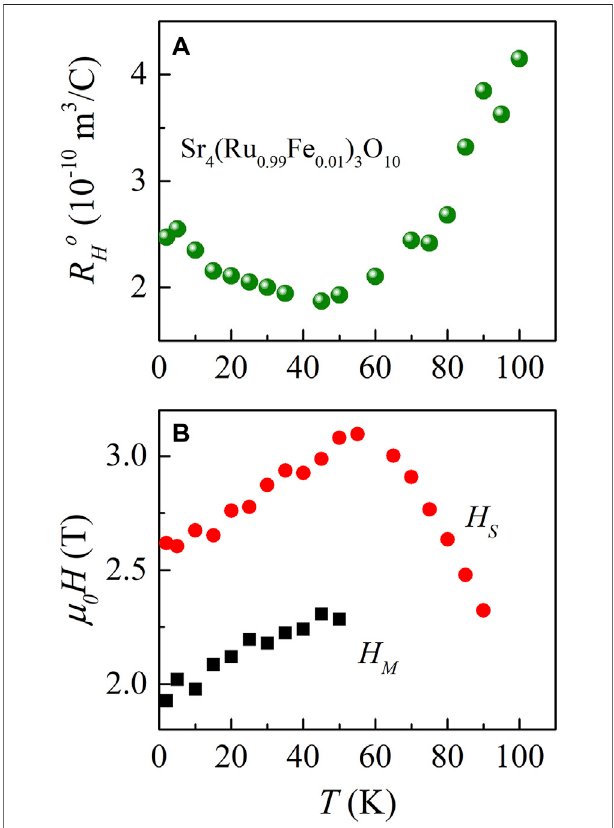
FIGURE 3 | (A) The ordinary Hall coef fi cient R Ho of the Sr 4 (Ru 0.99 Fe 0.01 ) 3 O 10 nanosheet as a function of temperature. (B) Temperature-dependent critical fi eld H M of the MMT and the saturation fi eld H S